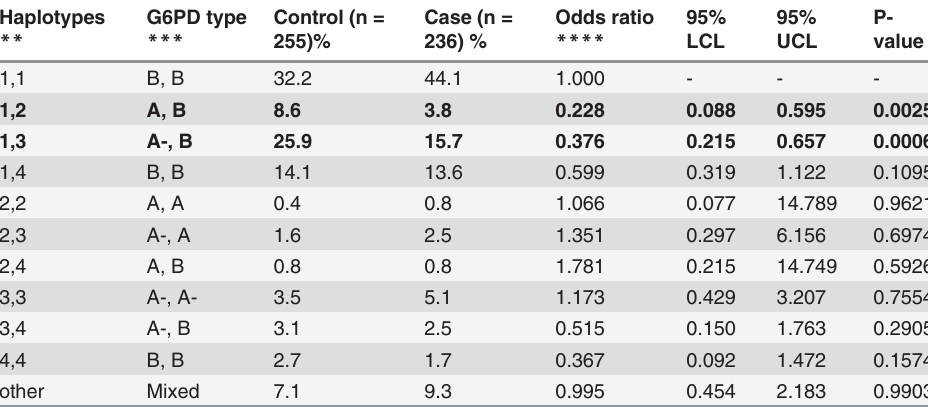
Table 3. Severe malaria and combinations of haplotypes. * Haplotypes